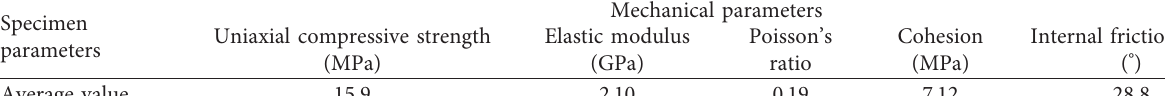
Table 1: Mechanical parameters of test piece.